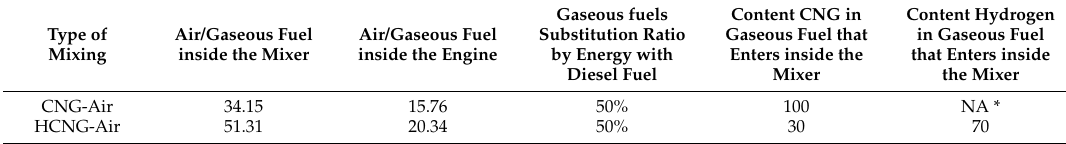
Table 5. Air-fuel ratio for CNG-Hydrogen-Diesel with air.